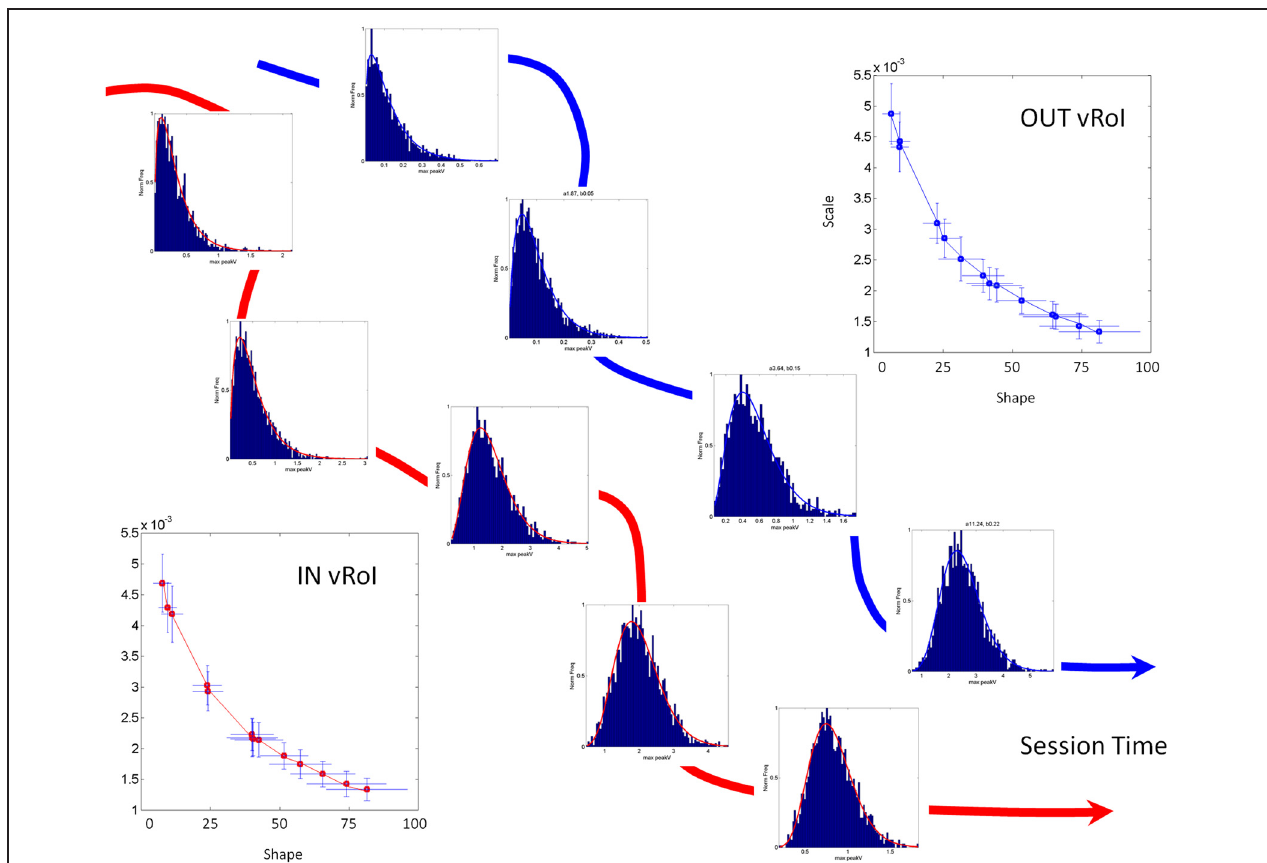
FIGURE 4 | Schematic explanation of the statistical platform for personalized behavioral analyses (SPBA) tracking the non-stationary statistics of continuous movements in real time. (The data sets in this schematic drawing were synthetically generated for explanation purposes using the actual Gamma estimates from a child’s behavior as the seeds). The fluctuations in the peak angular velocity of the sensor at the hand are accumulated as the wrist rotates while the child explores the peripersonal space with his/her hand. The fluctuations occurring IN vRoI (red) are accumulated in parallel to those occurring OUT vRoI (blue) in the continuous flow of motions of the hand’s behavior. Over time the behavior transitions from random to exploratory to systematic and goal directed, to intentional (as when the child deliberately holds the hand to sustain the media playing). In any given time period there can also be reversals toward a noisier random pattern as a function of the media. The faster the convergence toward